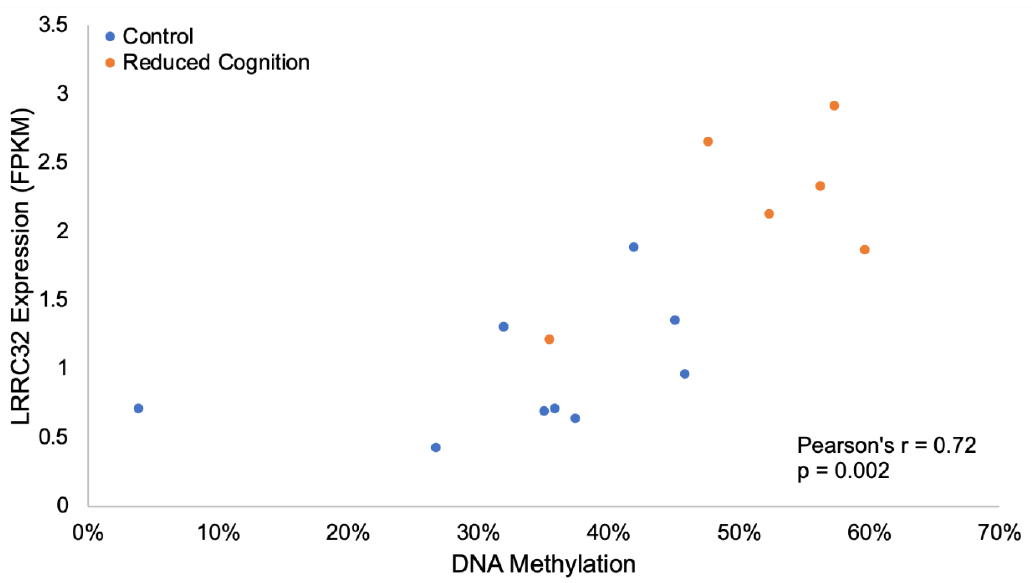
Figure 4. Di ff erential methylation and expression of LRRC32. Hypermethylation of a 60 bp region in the 2nd intron of LRRC32 correlated with increased expression in the reduced cognition group (Pearson’s R = 0.72, p -value = 0.002).